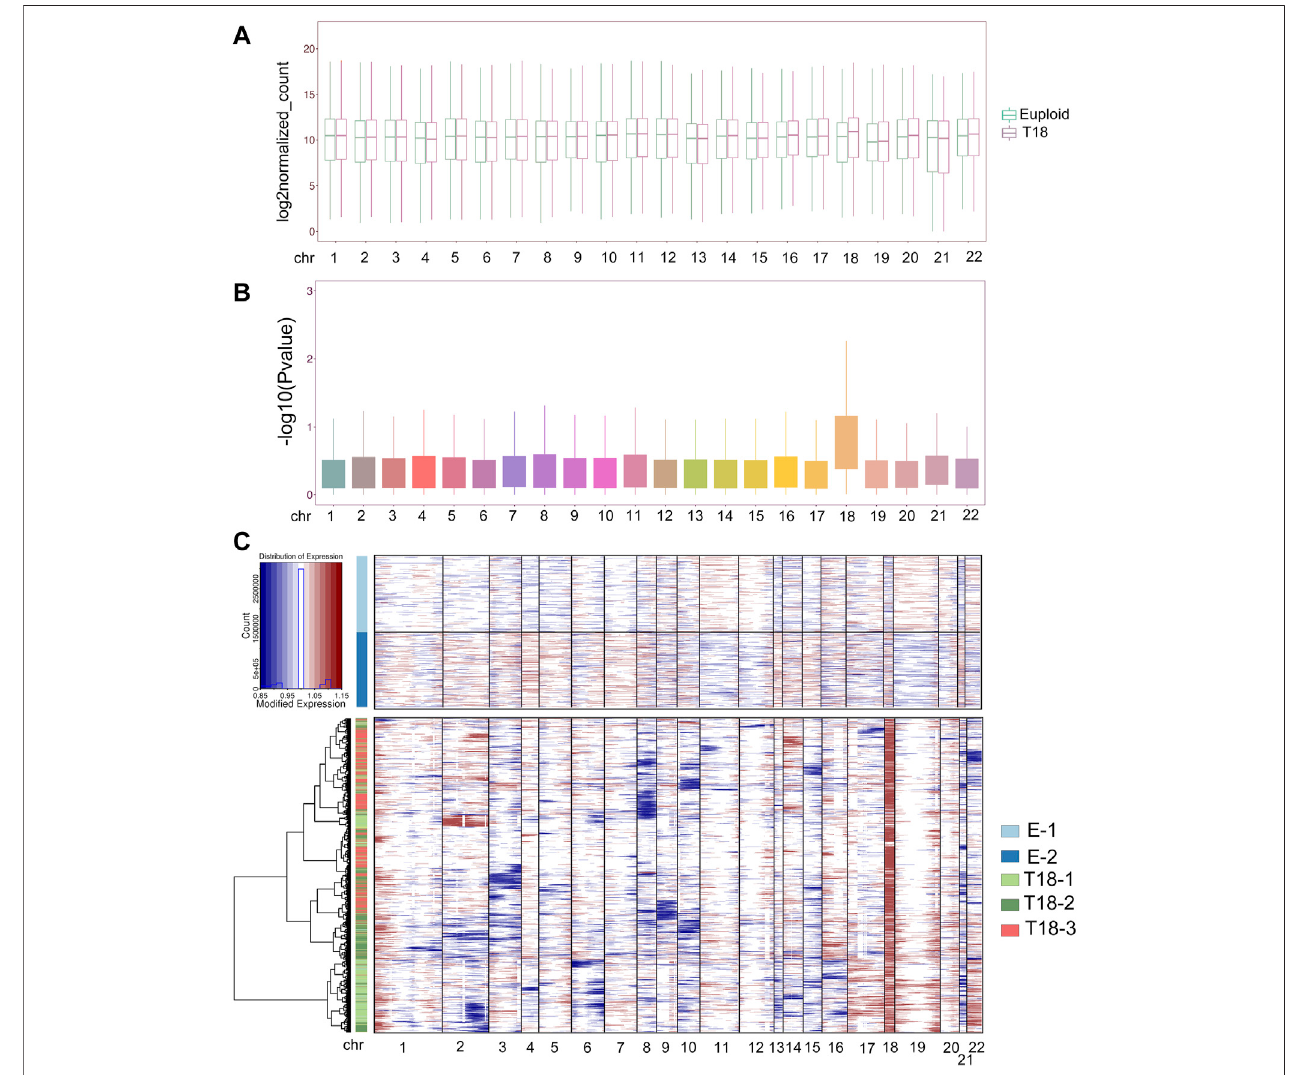
FIGURE3| Trisomy18altersgeneexpressiononchromosomes. (A) Mergedexpressionlevelsofgenes,showinglog2euploidizedcounts,oneachchromosome. (B) Up-regulated gene expression ( − log10 p -value) on chromosome 18 from trisomy 18 samples. (C) Heatmap of large-scale chromosomal copy-number variations (CNVs). Euploid cells served as reference cells, and trisomy 18 samples (T18-1, T18-2 and T 18-3) as observed cells.